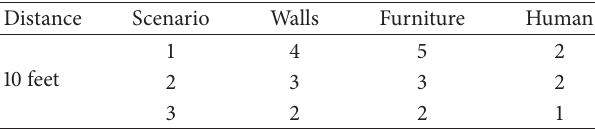
Table 1: Case 1 of experimental